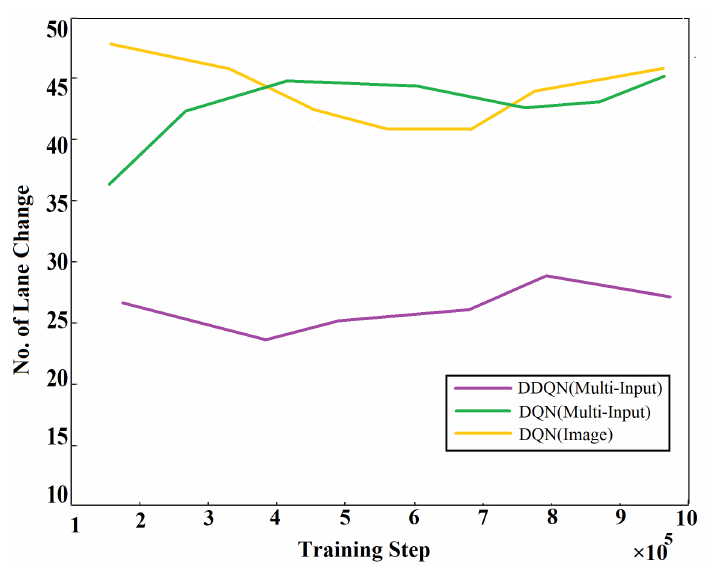
Figure 22. Lane changing comparison among different Q-Learning